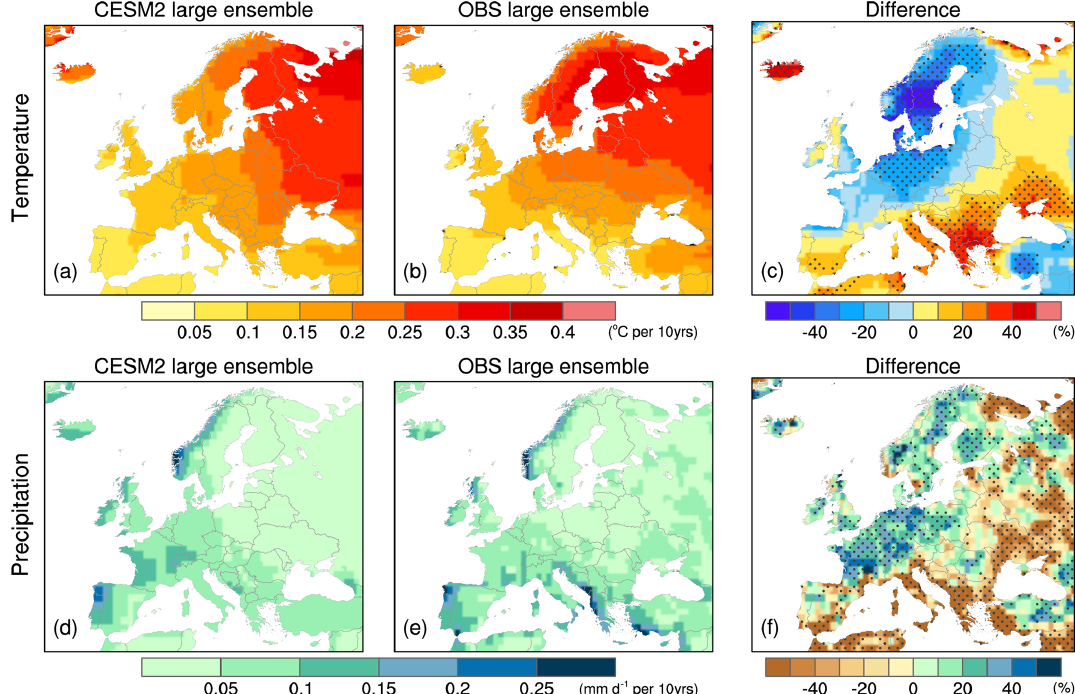
Figure 7. Standard deviation of 50-year trends (1972–2021) across 100 members of the CESM2 large ensemble (a, d) and 100 members of the observational large ensemble (b, e) , and their difference (c, f) for winter air temperature ( a–c ; ◦ C per decade) and precipitation ( d–f ; mmd − 1 per decade). Stippling in panels (c) and (f) indicates that the differences are statistically significant at the 95% confidence level according to an f